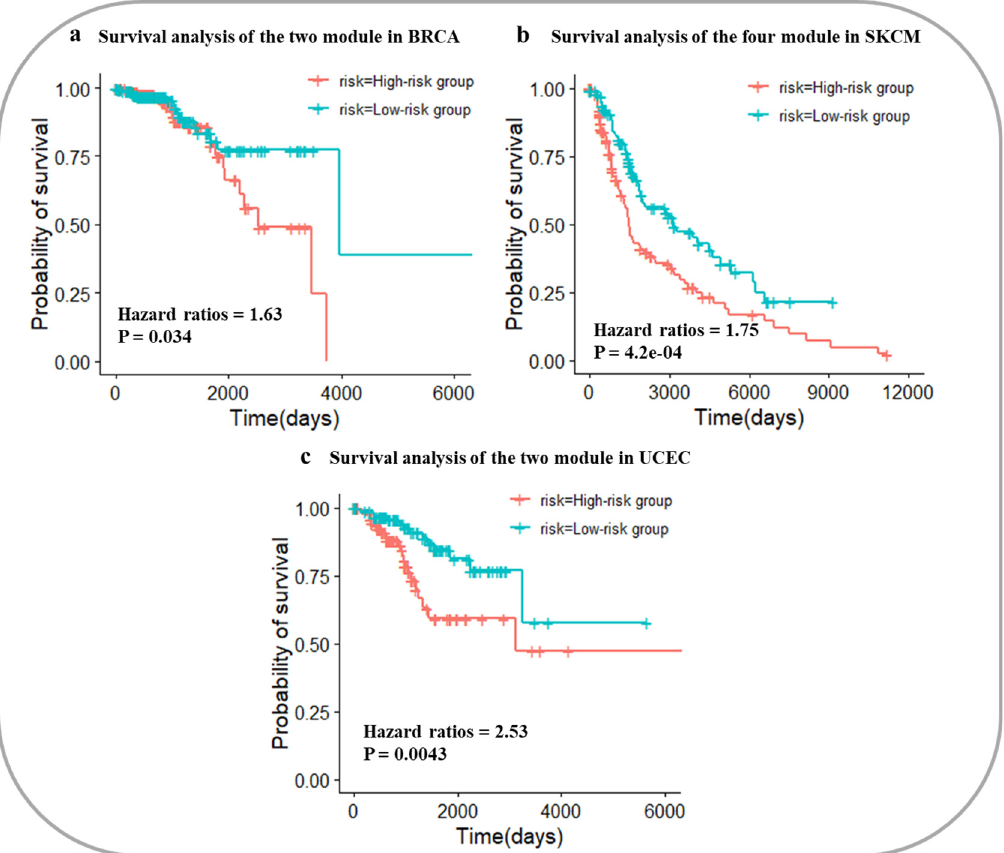
Figure 2. Survival analysis in the three cancer datasets based on core gene modules. ( a ) Survival analysis in the breast invasive carcinoma dataset; ( b ) Survival analysis in the skin cutaneous melanoma dataset; ( c ) Survival analysis in the uterine corpus endometrial carcinoma dataset. BRCA: breast invasive carcinoma; SKCM: skin cutaneous melanoma; UCEC: uterine corpus endometrial carcinoma.